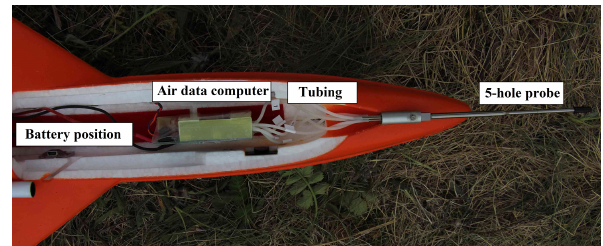
Figure 1. The 5HP and the data computer from Aeroprobe as mounted in the SUMO airframe.